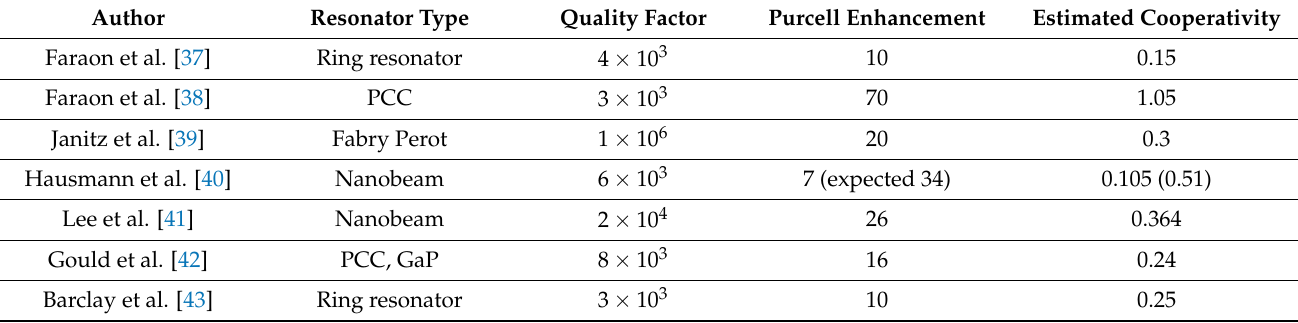
Table 1. Optical cavities for NV centers and their estimated cooperativities and quality